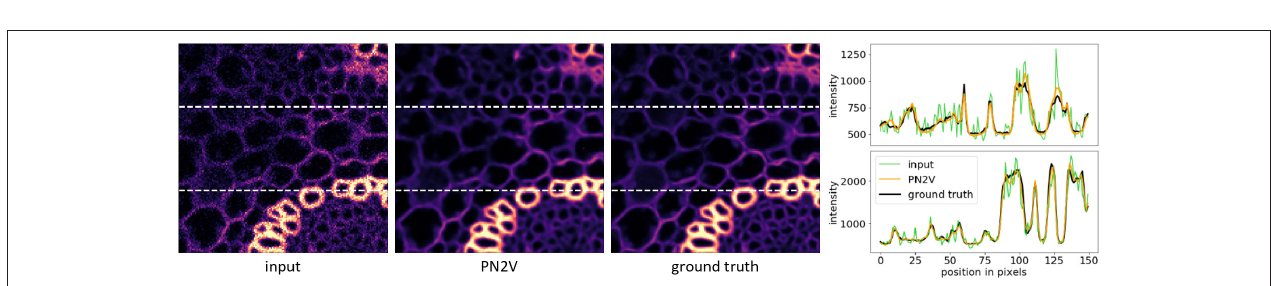
FIGURE 5 | Edge preservation in PN2V reconstructions. Here we show that the content-awareness of PN2V makes it perfectly capable of restoring sharp image gradients (edges). From left to right, we show an Convallaria image patch and the corresponding PN2V restoration and ground-truth. The rightmost column shows line-plots along the dashed white lines in all three